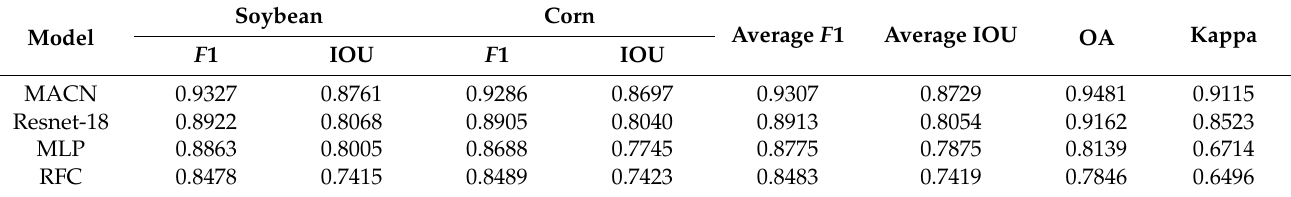
Table 2. The classification accuracy of crop classification using the different